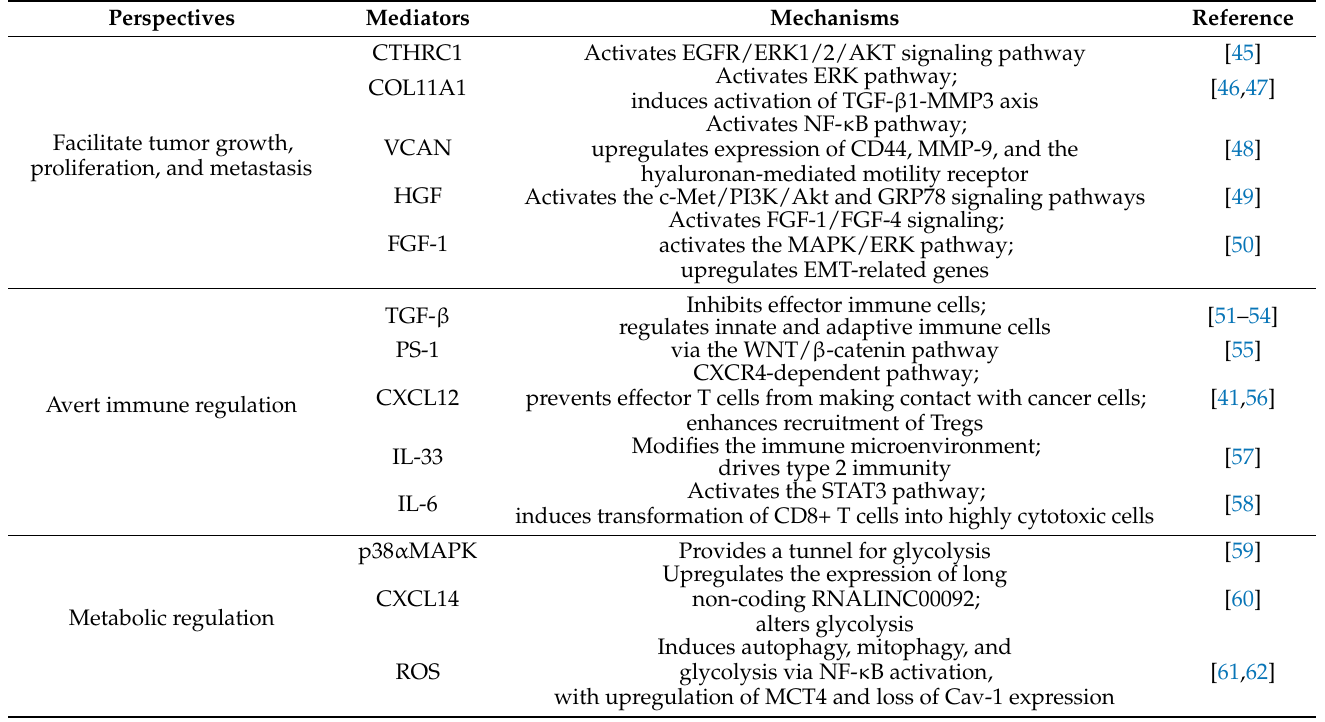
Figure 3. Mechanisms of CAFs in ovarian cancer progression and dissemination. CAFs can regulate the growth, proliferation, and metastasis of ovarian cancer in different ways, including ( a ) secreting cytokines, ( b ) shaping the immune microenvironment, and ( c ) establishing metabolic crosstalk. Image created with BioRender.com (accessed on 24 April 2022). Table 1. Mechanisms used by CAFs to promote ovarian cancer biological processes.